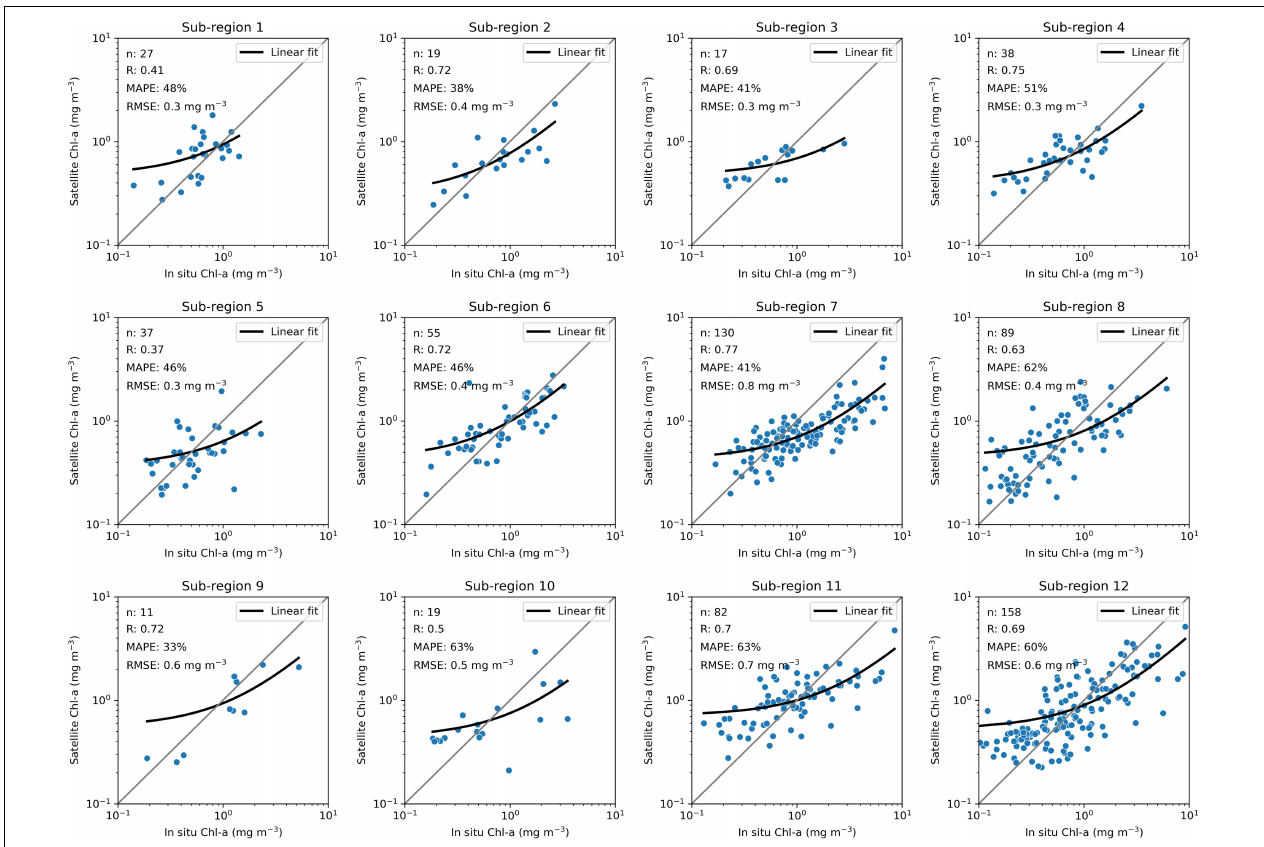
FIGURE 3 | Comparison between in situ and satellite Chl-a concentration for each sub-region. The black line is a linear model fitted using least squared regression, and it is curved due to the axes log